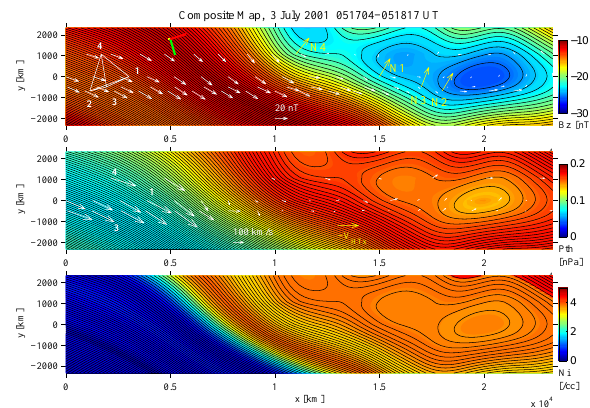
Fig. 5. Composite maps produced for the interval 1 by superposing and averaging the four field maps shown in Fig. 4 (see text for de- tails). In the reconstruction plane, the spacecraft move from left to right: the magnetosphere where B x > 0; B y < 0 is on the lower left side and the magnetosheath ( B x < 0; B y > 0) is on the upper right side. Color-coded in the panels are the magnetic field component normal to the plane, plasma pressure, and ion density, respectively. In the top panel, white arrows anchored at points along the space- craft trajectories represent the measured magnetic field vectors; yel- low arrows show the boundary normals, N 1 − N 4, determined for each spacecraft by MVAB with constraint h B n i =0; line segments in the upper part are GSE unit vectors, X (red), Y (green), and Z (yel- low), projected onto the x − y plane. In the middle panel, the white arrows represent the ion bulk velocity vectors from CIS/HIA (C1 and C3) or from CIS/CODIF (C4), transformed into the HT frame. GSE coordinate axes of the map are x =(0.9483, 0.2867, − 0.1359), y =(0.2895, − 0.9572, 0.0006), z =( − 0.1300, − 0.0399, −